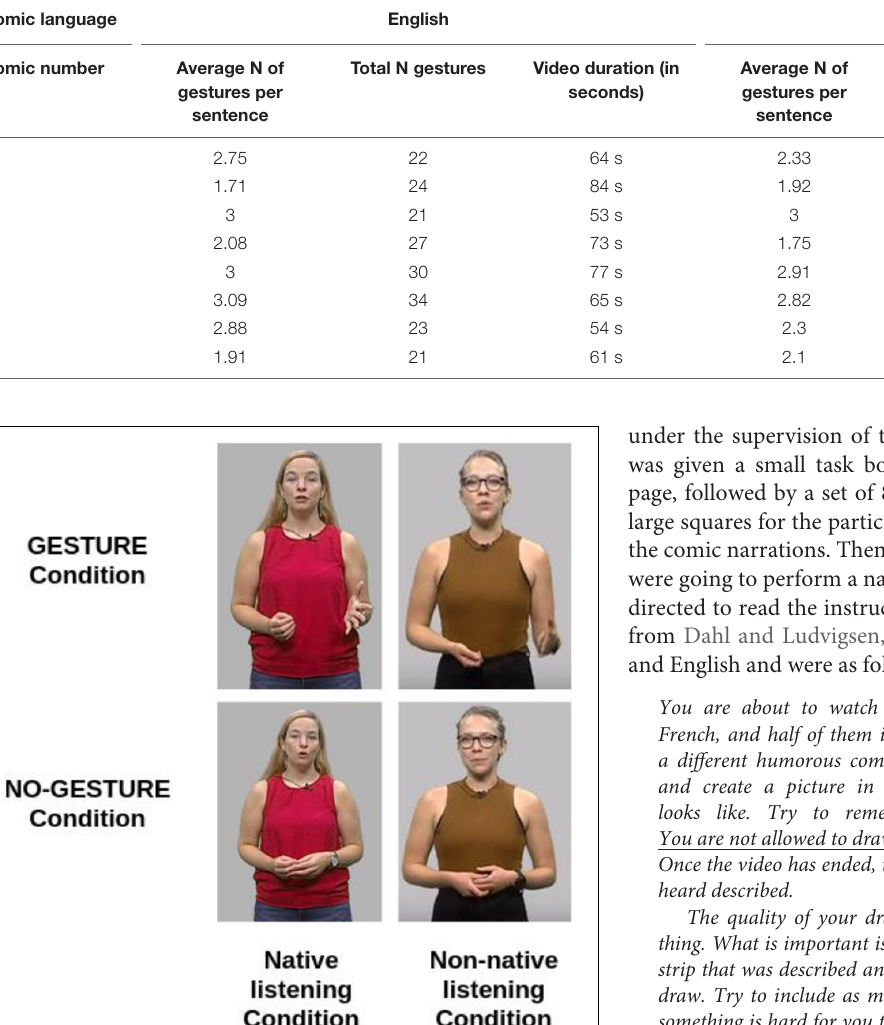
TABLE 1 | The average number of gestures per sentence, and total number of gestures per comic narrations.